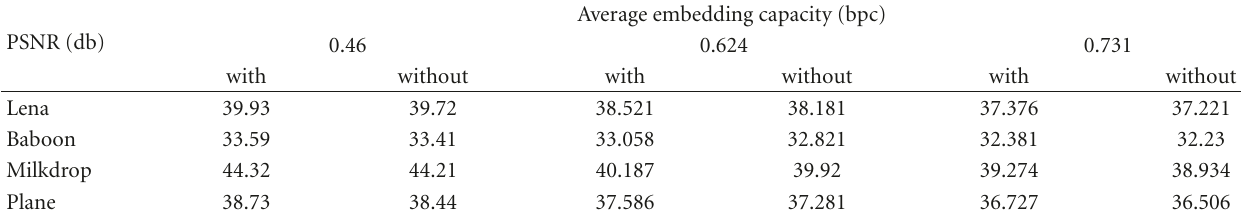
Table 1: PSNR of gray images embedded by IA-LSB with and without shu ffl ing message bits, simply denoted as “with” and “without”. PSNR (db)